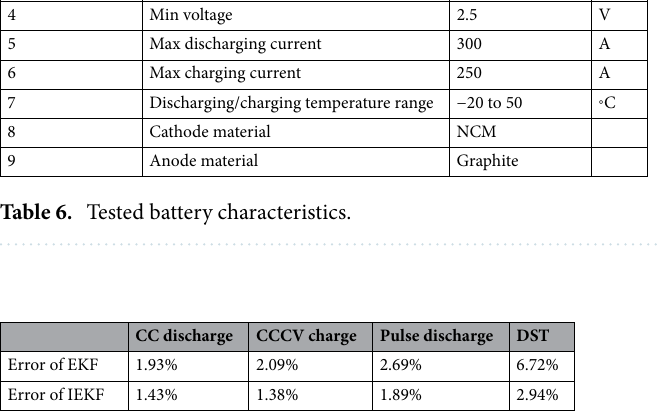
Table 7. Precision comparation with IEKF and